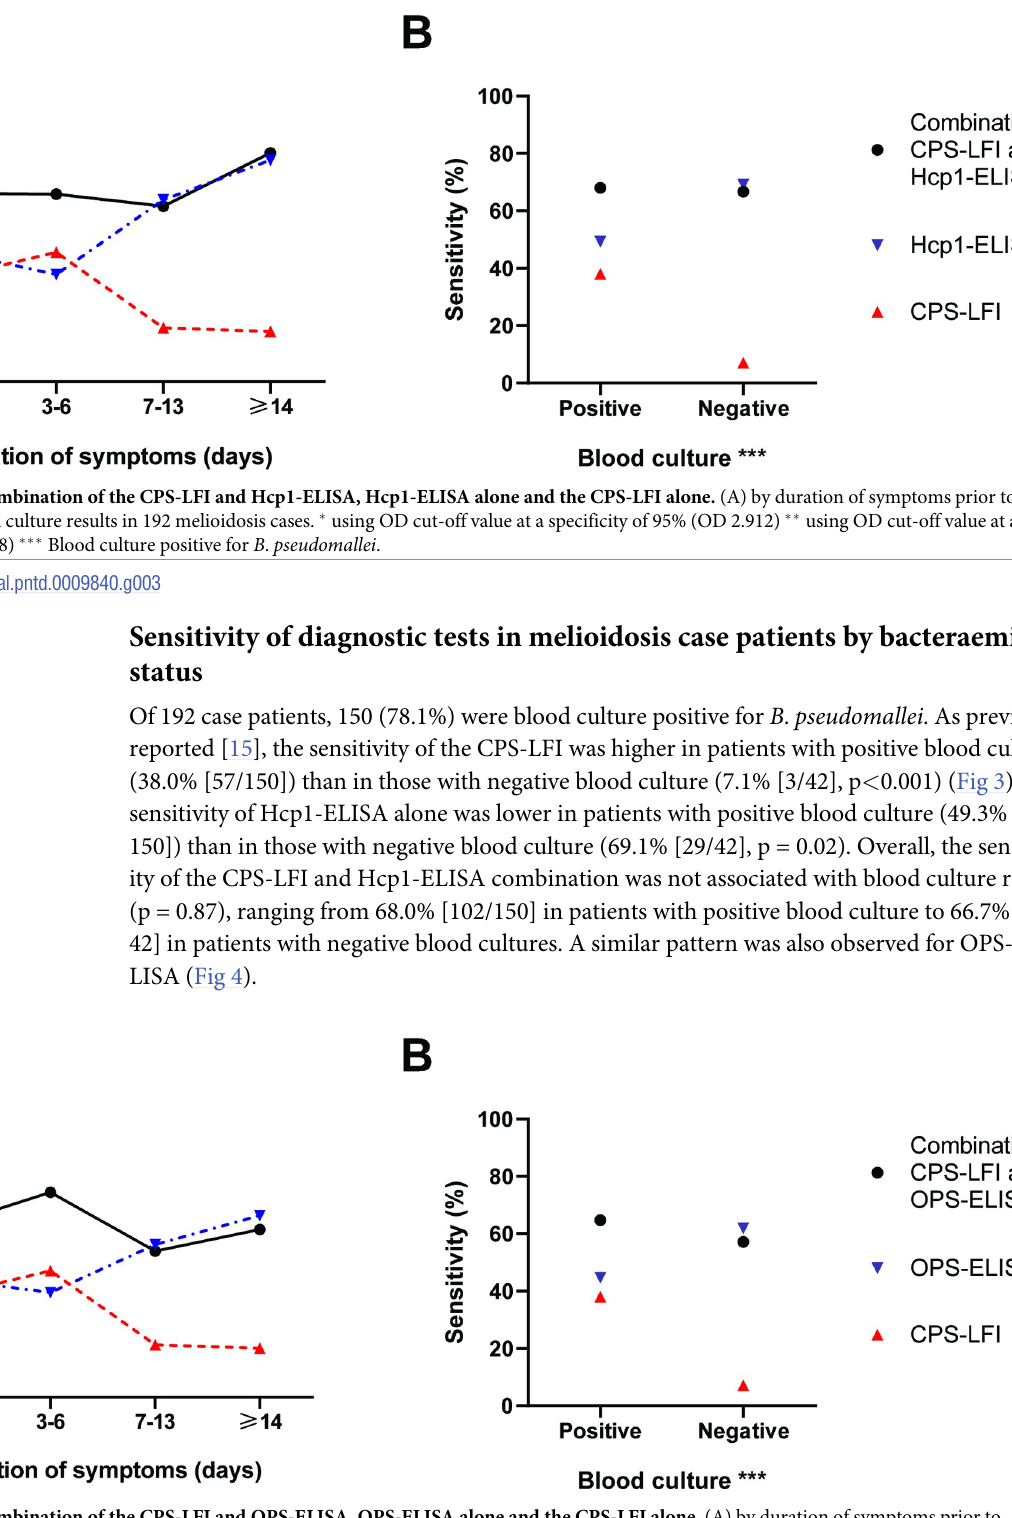
PLOS NeglectedTropical Diseases | https://doi.org/10.1371/journal.pntd.0009840 November2,